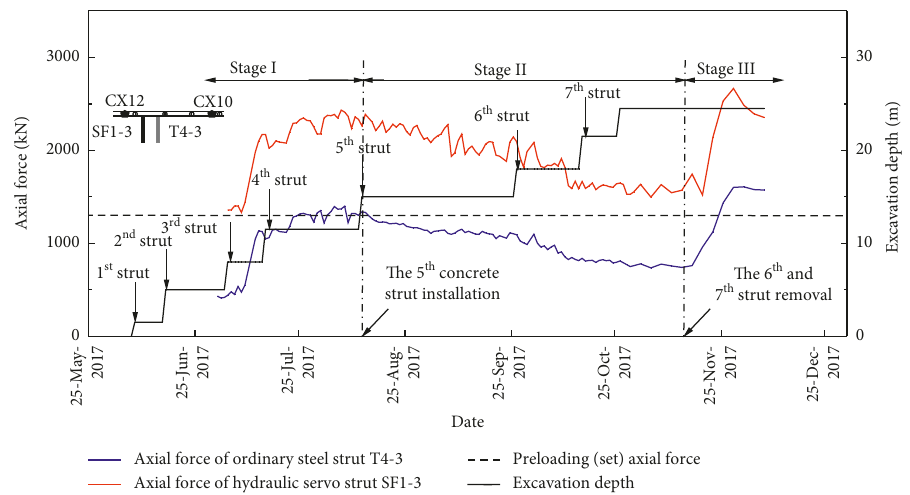
Figure 16: Changes in the trend of the axial force of the steel struts. Table 2: Axial force loss in ordinary steel